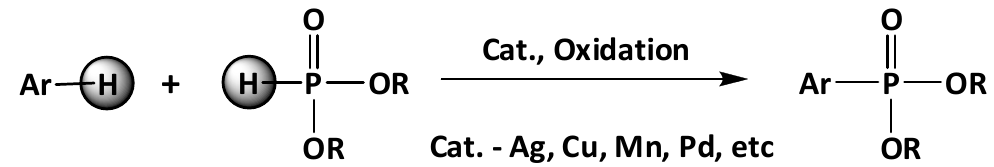
Scheme 1. Phosphonation of aromatic compounds by dialkyl- H -phosphonates under